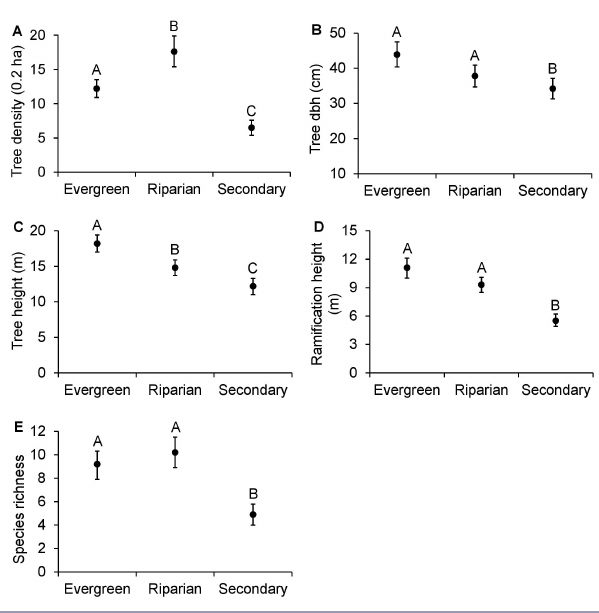
Fig. 3 . Variation among forest types in metrics of trees (≥ 10 cm dbh) within a 25-m radius of point counts for (A) tree density in 0.2 ha, (B) tree diameter at breast height (cm), (C) total tree height (m), (D) ramification height to the first major branch (m), and (E) tree species richness, in tropical moist forest of Los Chimalapas, Mexico. Mean values per point count with 95% confidence intervals are shown. Letters indicate significantly different Dunn posthoc pairwise comparisons among forest